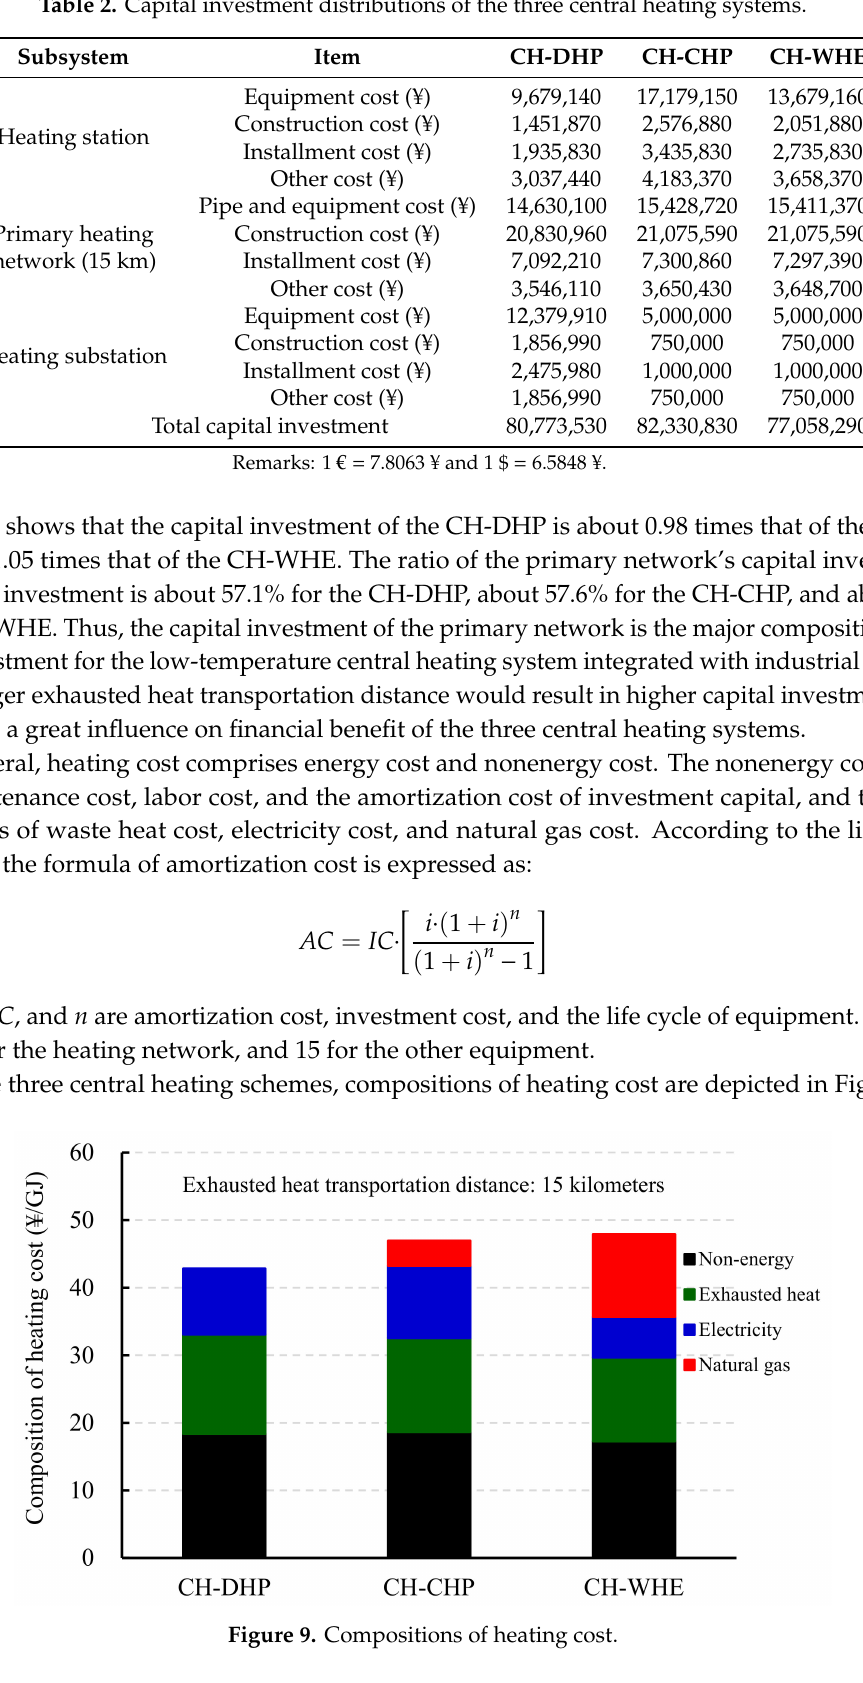
Table 2. Capital investment distributions of the three central heating systems.